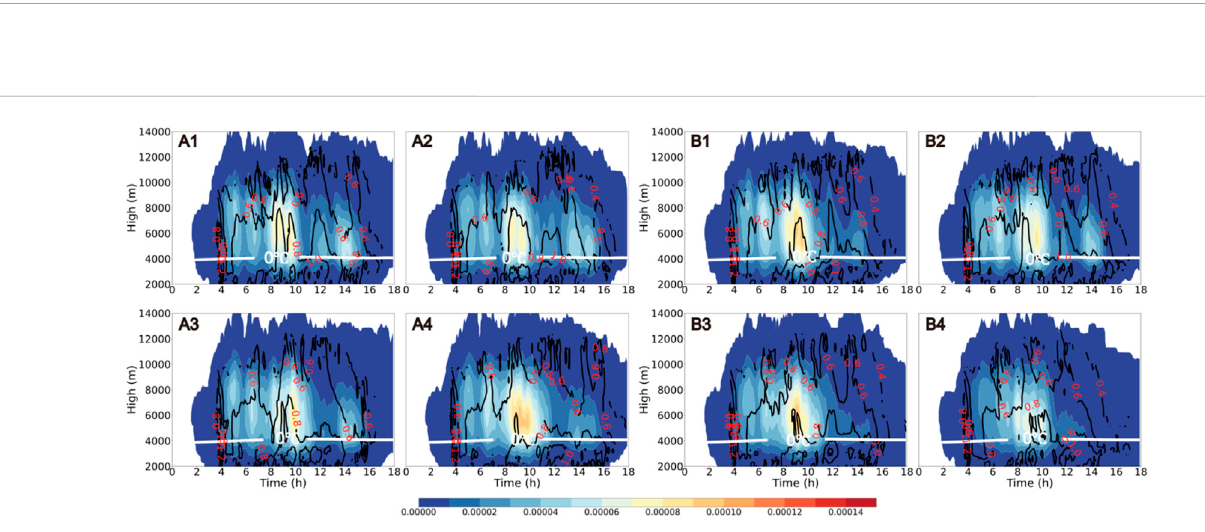
Timevariationoftheheightdistributionofgraupelparticlemixingratio(Unit:g kg − 1 )withthecontourofthemass-weightedaveragediameter(Unit:mm), and the solid white line is the height of 0 ° C (A) TH-AU. (B) MY-AU; (1) NCCN50 (2) NCCN200 (3) NCCN 2000 (4)